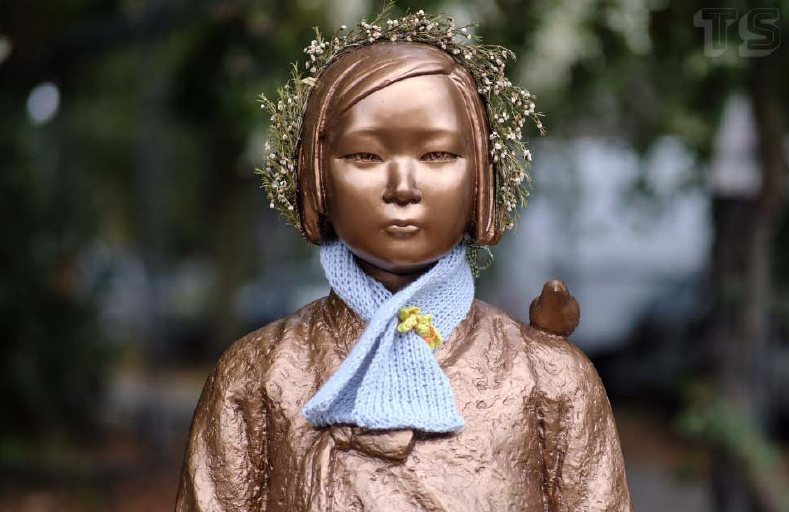
Figure 1. A monument in Berlin commemorating ‘comfort women’, Korean victims of Japanese sexual violence during World War II. Municipal authorities decided to remove the memorial in response to pressure from the Japanese government. However, local activists resisted the removal, and it was temporarily halted. Berlin